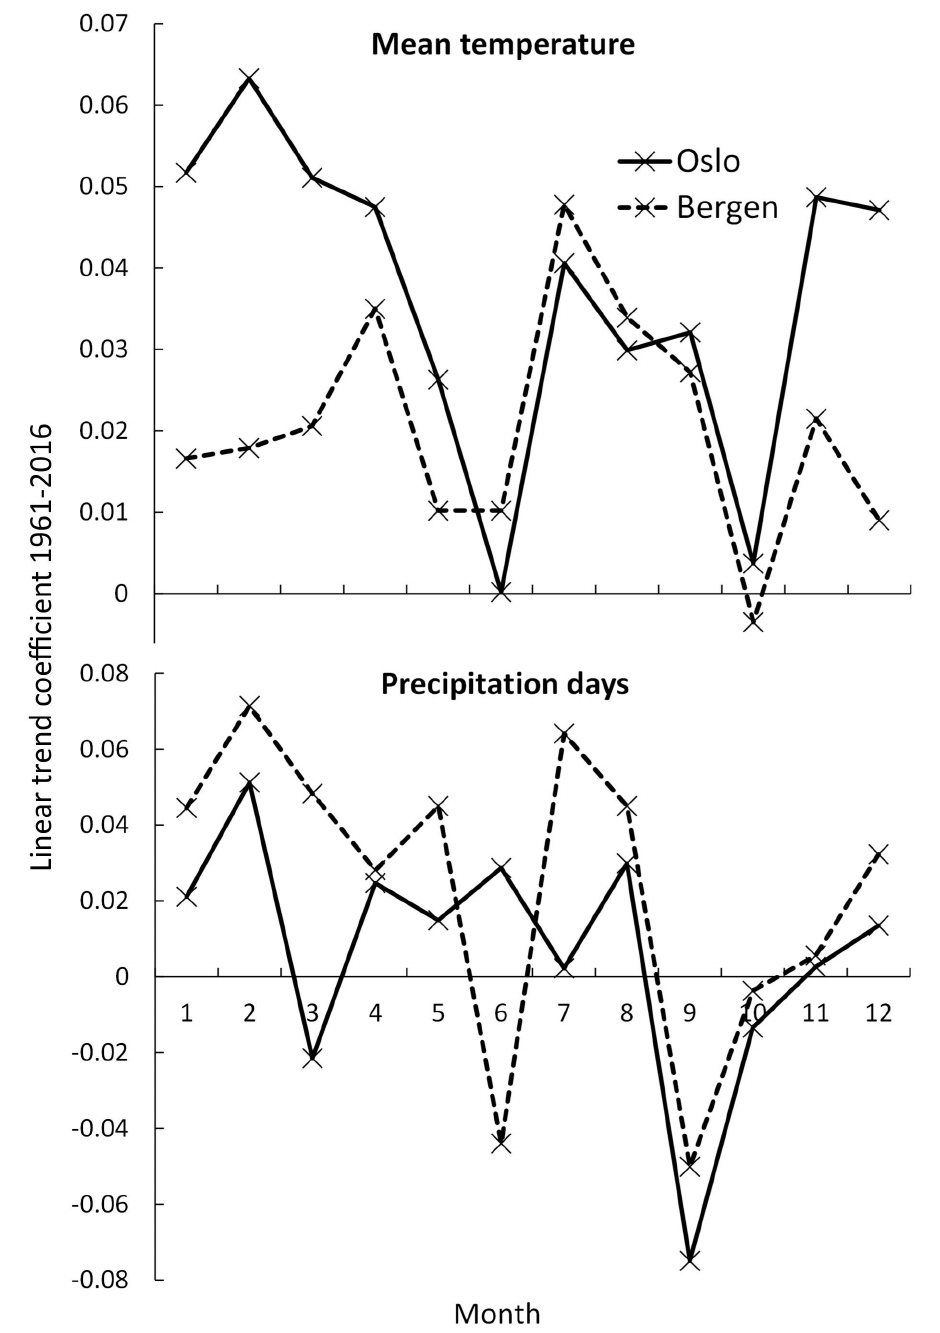
Figure 6. The linear trend coefficient values for the monthly mean temperature and the number of days per month with precipitation over 0.25 mm from 1961 through to September 2016 in Oslo and